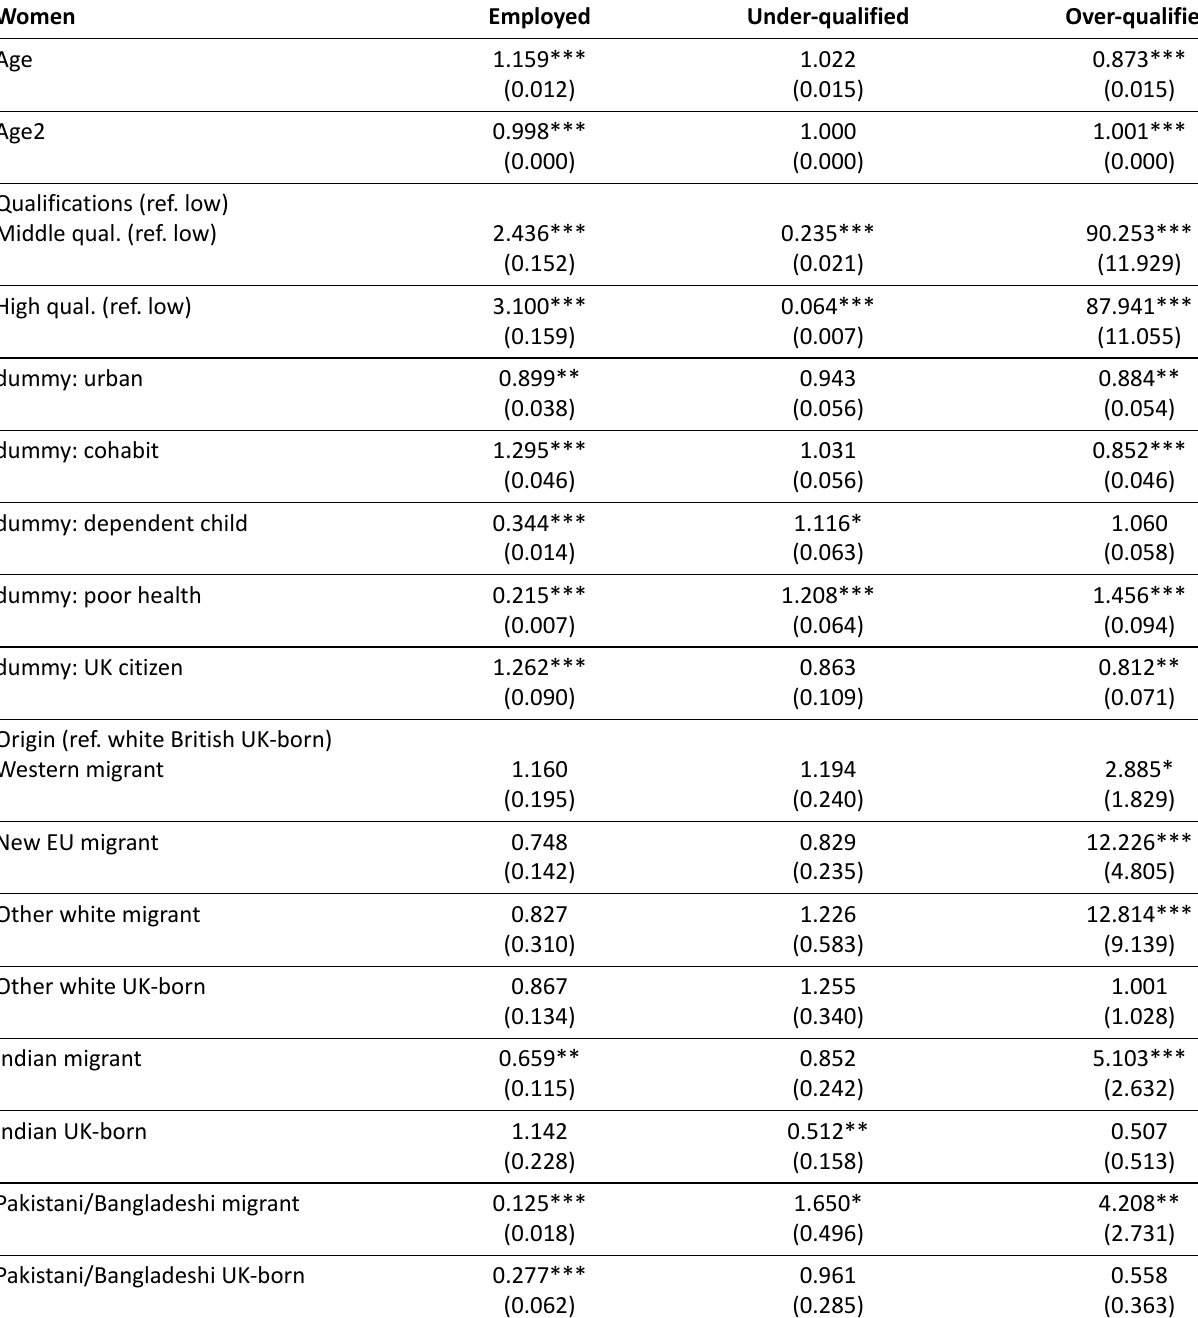
Table A4. Binary logistic regression model (odds ratio) of employment, under- and over-qualification for